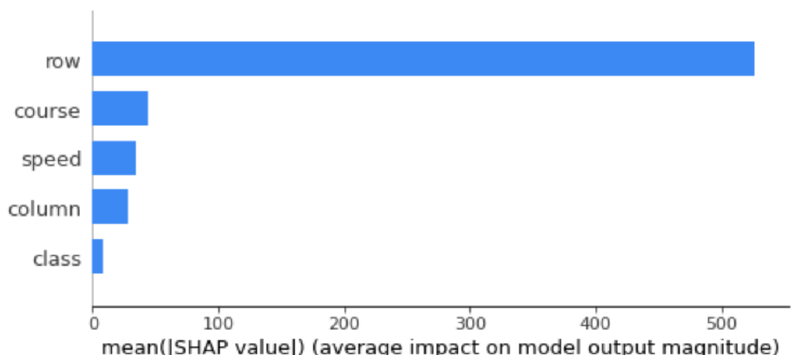
Figure 10. The contribution of each input feature to build the output predicted by KNN-WD for ship 81.